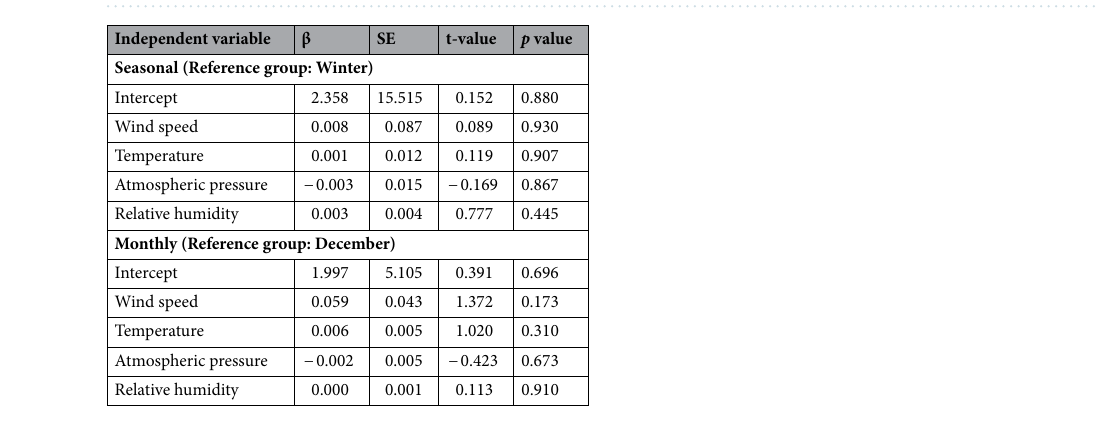
Figure 2. Seasonal ( A , B ) and monthly ( C , D ) incidence of Bell’s palsy [( A , C ) average temperature and average relative humidity, ( B , D ) average atmospheric pressure, per 100,000 persons].